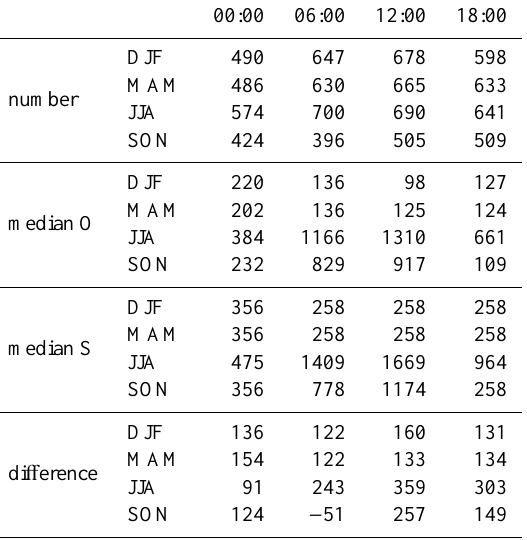
Table 2. Statistical parameters of the comparison between observed and simulated PBL height, split for sounding times in column 3 to 6, and seasons in rows according to the abbreviation in column 2. Listed are the number and the median of used observed values (me- dian O), median of simulated values (median S), and the di ff erences of the medians. Unit of the last three variables is